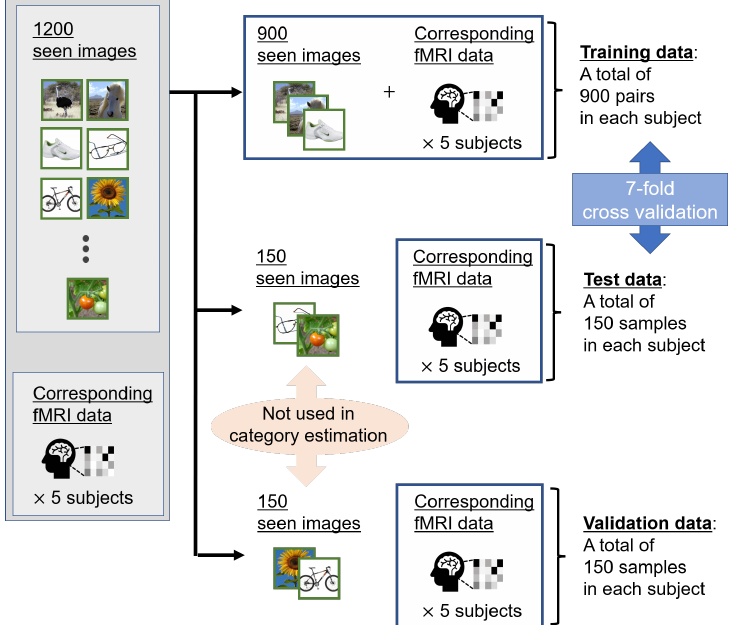
Figure 3. Overview of fMRI datasets of five subjects. We divided a total of 1200 seen images corre- sponding to measured fMRI data into 900, 150, and 150 images as training, test, and validation data, respectively. The validation data were fixed, and 7-fold cross-validation was applied to 1050 pairs of the training and test data. For category estimation, we used the candidate visual features averaged from other images belonging to the same seen category. Thus, the seen images were not included in the test and validation